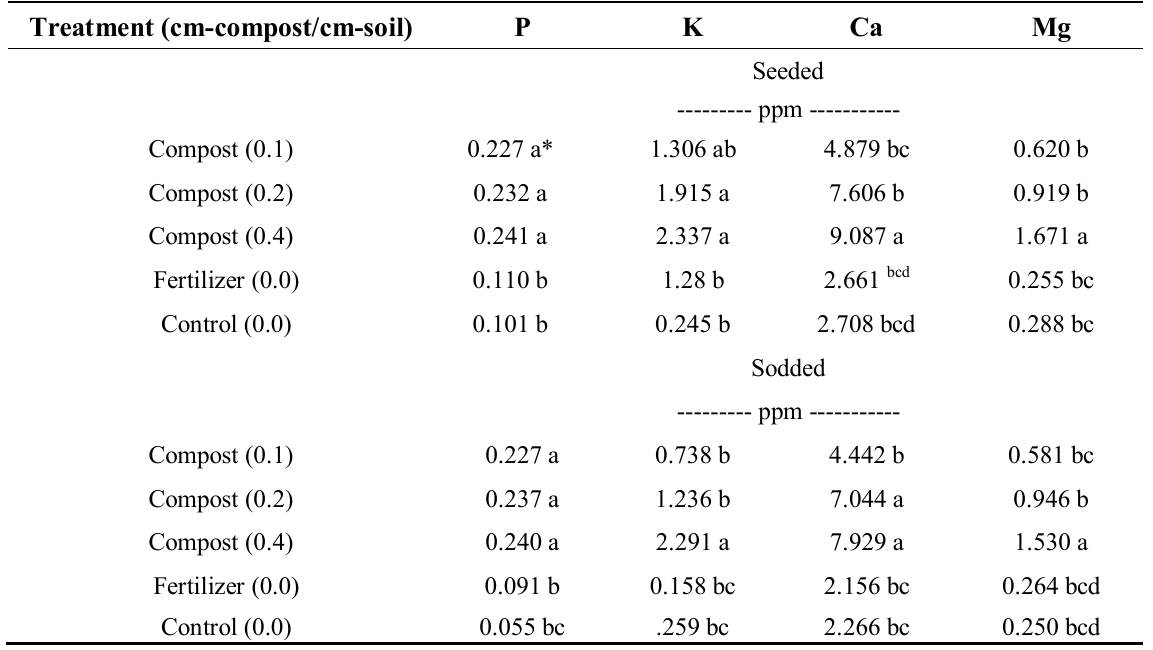
Table 1. Effect of incorporating composted poultry litter into top 12.7 cm of subsoil on its mineral nutrient content; * Means with same letters are statistically insignificant based on Fisher’s Protected LSD test ( P ≤